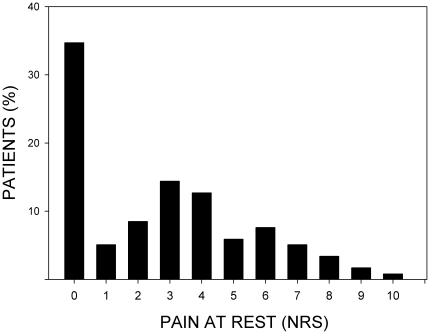
Pain at rest by means of Numeric Rating Scale (NRS).0 indicates no pain at rest, and 10 indicating the worst pain. Bars display the percentage of patients in the respective category. The majority of patients (77/118 = 65.3%) reported spontaneous ongoing pain (44 patients with pain scores ≥4 = 37.3%). Mean NRS-score: 2.8±2.7; median NRS-score: 3.